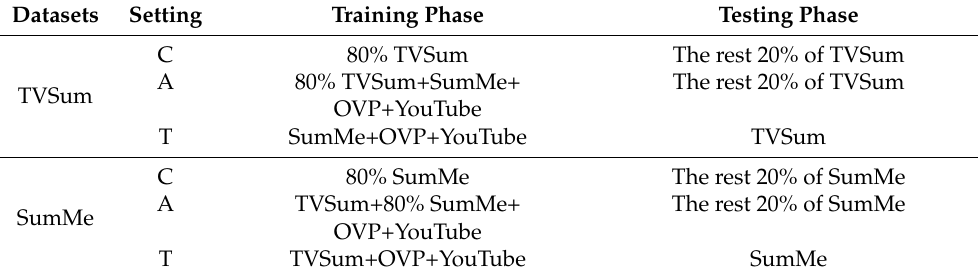
Table 2. Datasets setting used for evaluation (C: Canonical; A: Augmented; T: Transfer).